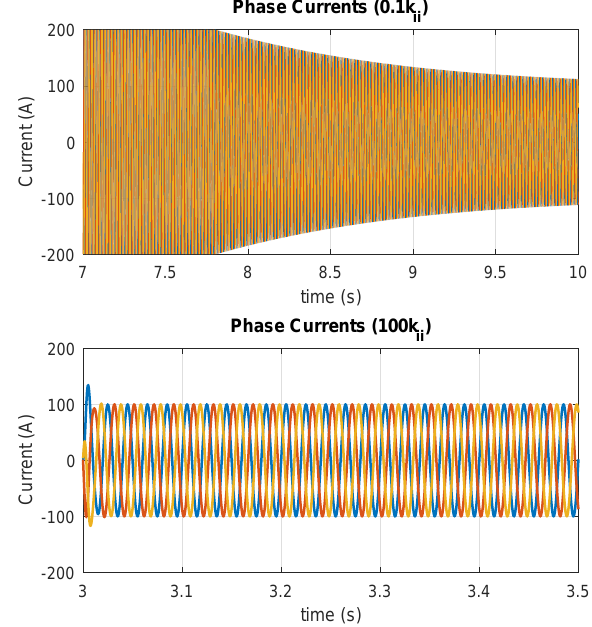
Figure 14. ( Top plot ) time domain plot of phase currents in abc frame, for the case with 0.01 × k ii showing poor steady-state accuracy; ( Bottom plot ) 100 × k ii